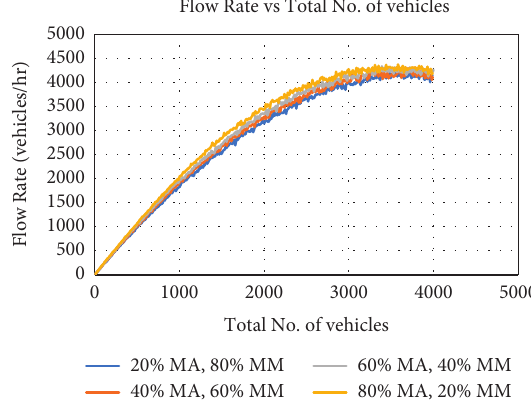
Figure 30: Flow rate vs. no. of vehicles fundamental diagrams for different compositions of MA and MM.